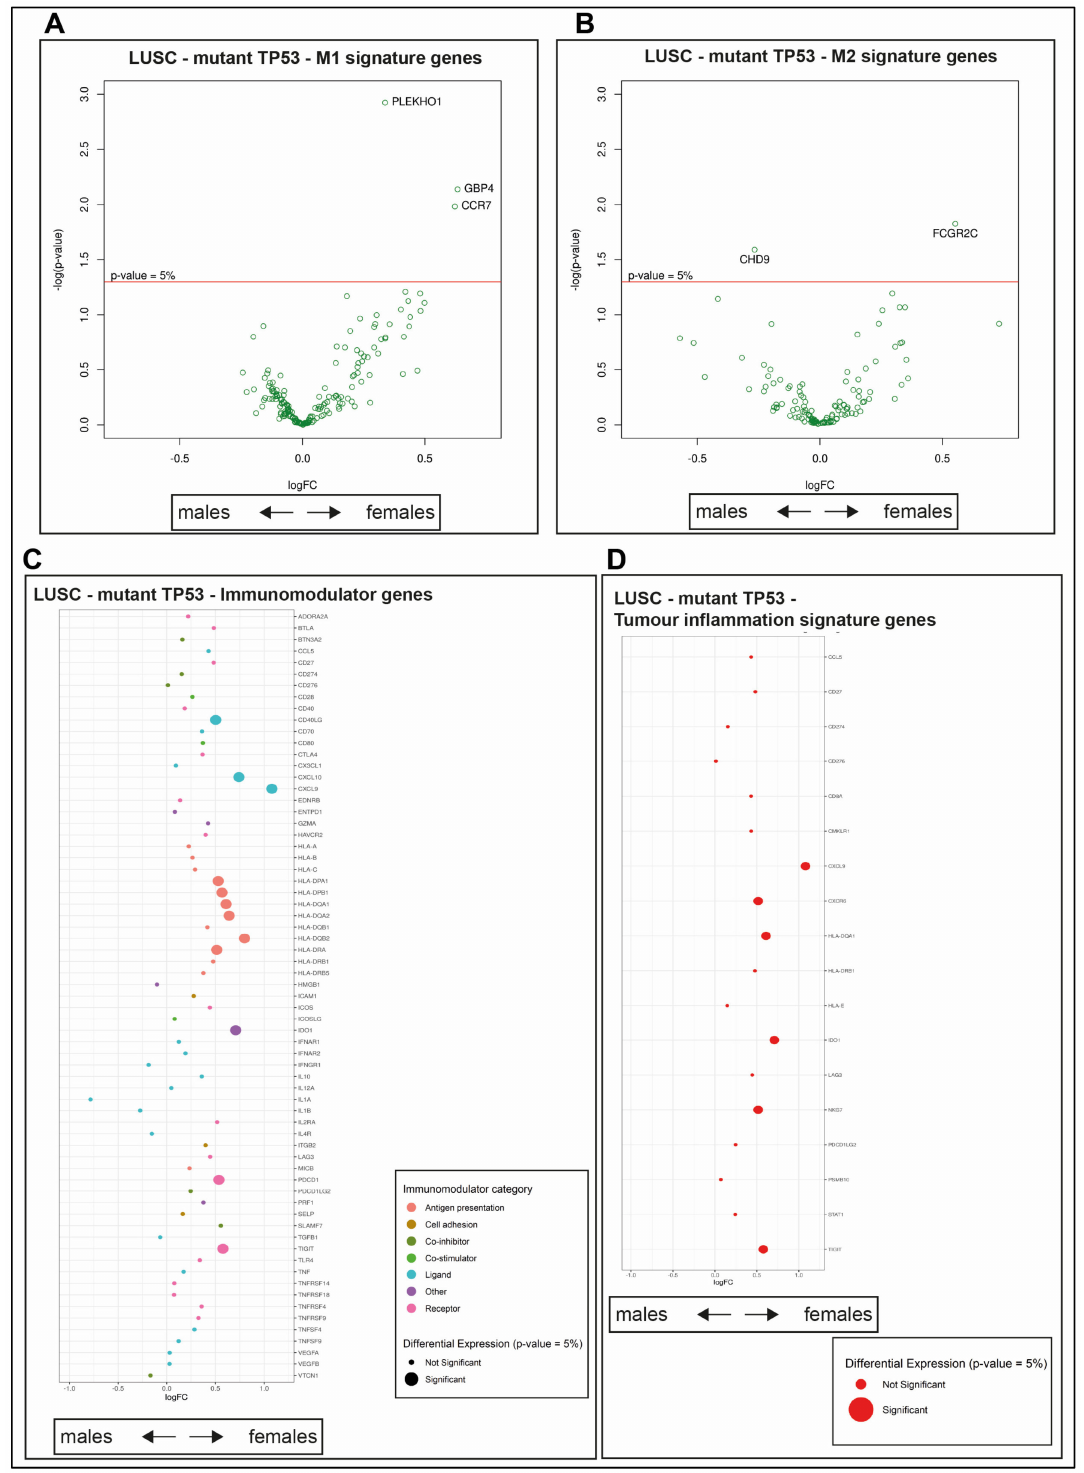
Figure 7. Sex disparity in expression of immune genes in mutant TP53 LUSC. Di ff erential expression analysis of ( A ) M1 and ( B ) M2 macrophage genes (with gene name assignment for p -values < 0.05) ( C ) di ff erential expression of immunomodulator gene signature genes, and ( D ) di ff erential expression of tumor inflammation signature (TIS) genes. Significantly enriched genes ( p -value < 0.05) are denoted by a large dot. A positive log fold change (logFC) demarks higher di ff erential gene expression in females, while negative values indicate higher levels in